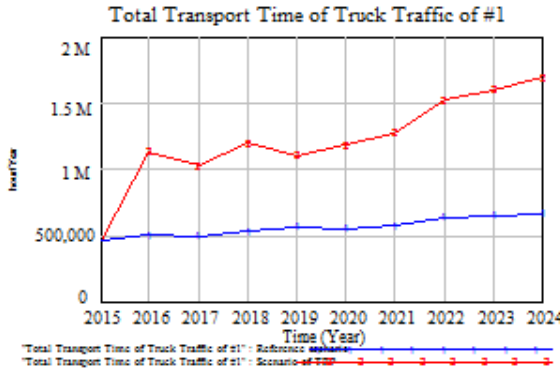
Figure 6. TRP effects on the total transport time of truck traffic on the express